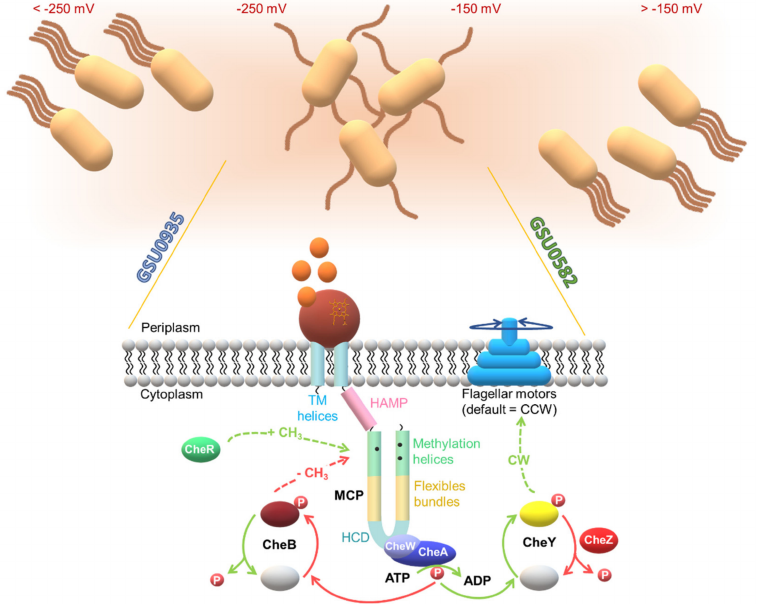
Figure 15. Model for the signal transduction mechanism mediated by MCP in G. sulfurreducens . Signal sensing promotes the phosphorylation of CheA coupled by an adaptor protein CheW. The cascade continues with the phosphorylation of CheY. CheY~P is responsible for clockwise flagellar rotation (CW) and tumbling movements dominate. On the other hand, signal saturation blocks the cascade and the reverse events occur. In this case instead of tumbling, running movements predominates because of the counterclockwise flagellar rotation (CCW). Once a directional flagellar motion is no longer necessary, the phosphatase CheZ oligomerizes with the phosphorylated CheY and increases the spontaneous dephosphorylation rate of CheY ∼ P. Then, adaptation follows: CheB causes demethylation of the methylated MCP, while CheR causes its